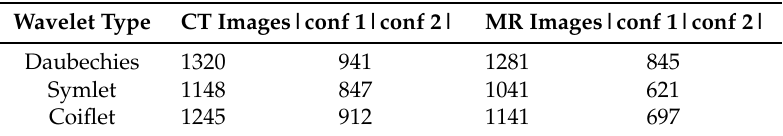
Table 4. A comparison of time consumption (calculated in seconds) for Salt and Pepper noise for CT and MR images and individual Wavelet families.